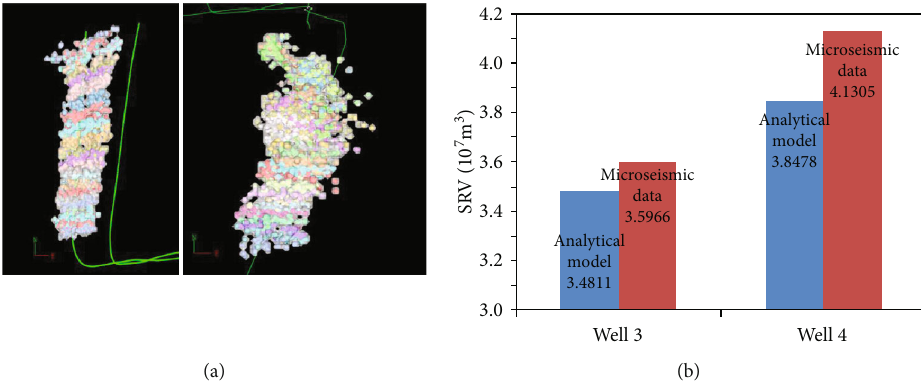
Figure 11: (a) Renderings of microseismic detection technology for Well 3 and Well 4. (b) Comparison between the analytical model and the microseismic